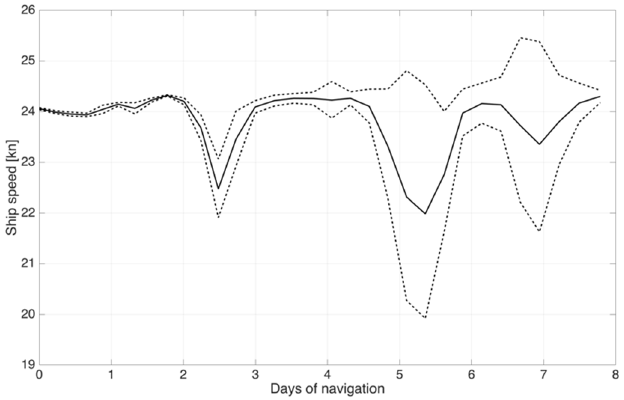
Figure 5. Evolution of mean value of 𝑉 (cid:3020) and 90% confidence interval along the route applying the first-order second-moment method.